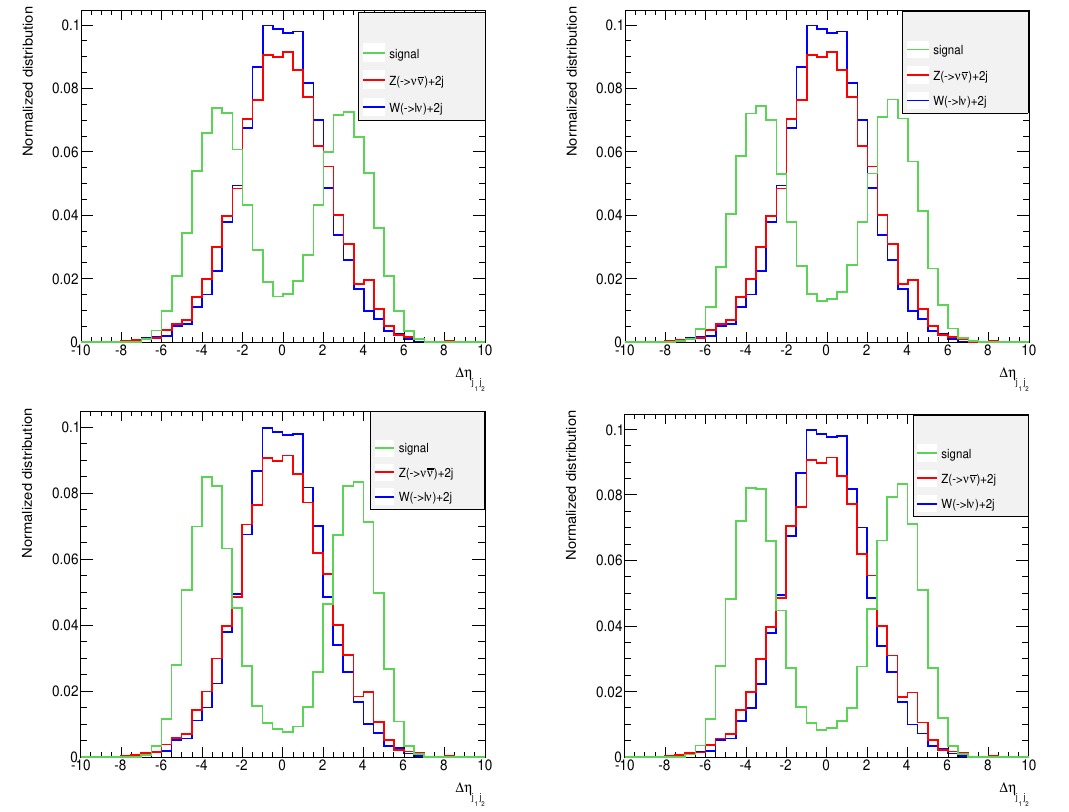
Figure 13 . (cid:1) (cid:17) distribution between the two forward jets for vector boson fusion signal and background processes, Type I BP I(top left), Type I BP II(top right), Type II BP I(bottom left) and Type II BP II(bottom right).